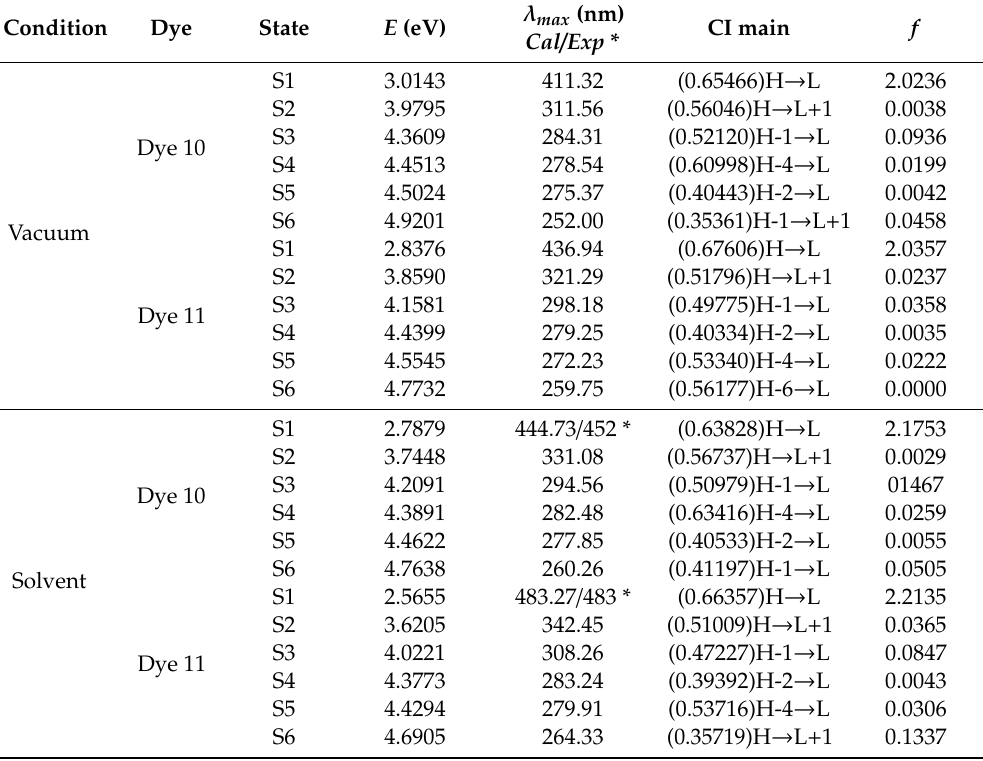
Figure 4. ( a ) The absorption spectra of molecules TPCTh and TPCRh in vacuum (solid lines) and solvent (dotted lines). ( b ) The absorption spectra of the molecules 10 and 11 in vacuum (solid lines) and solvent (dotted lines). Table 4. Transition energies (eV), absorption peaks (nm) and oscillator strengths of the two molecules in vacuum and